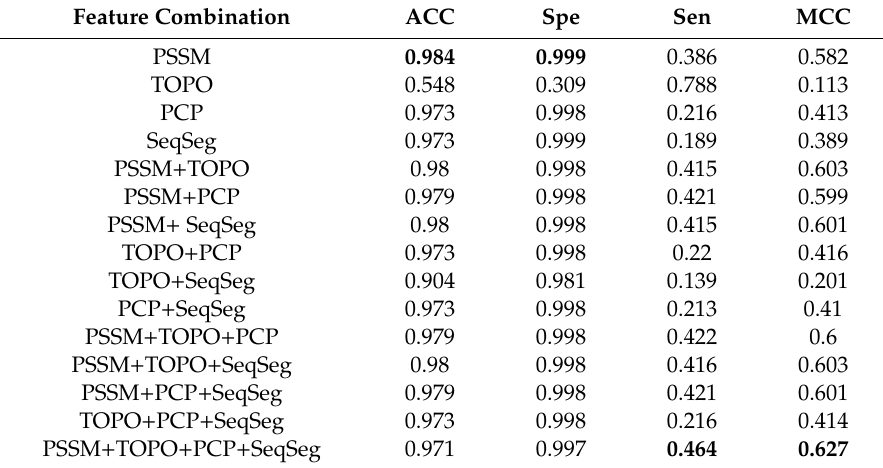
Table 1. The performance of di ff erent combinations of features.